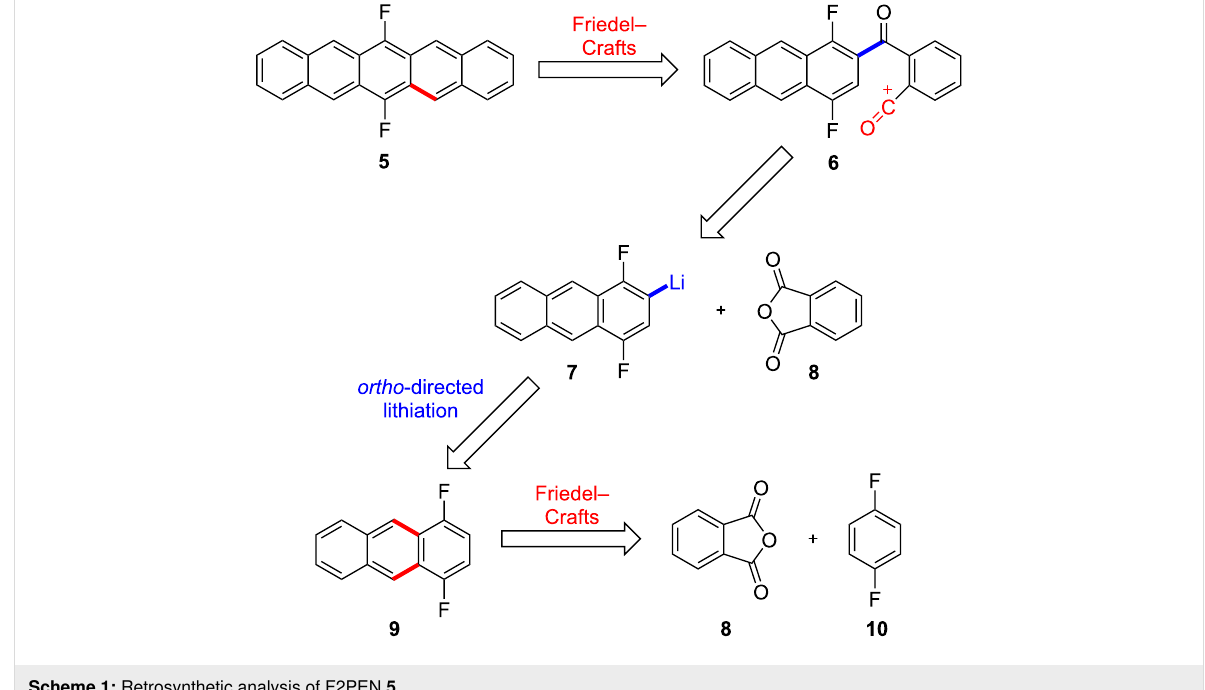
Scheme 1: Retrosynthetic analysis of F2PEN 5 .